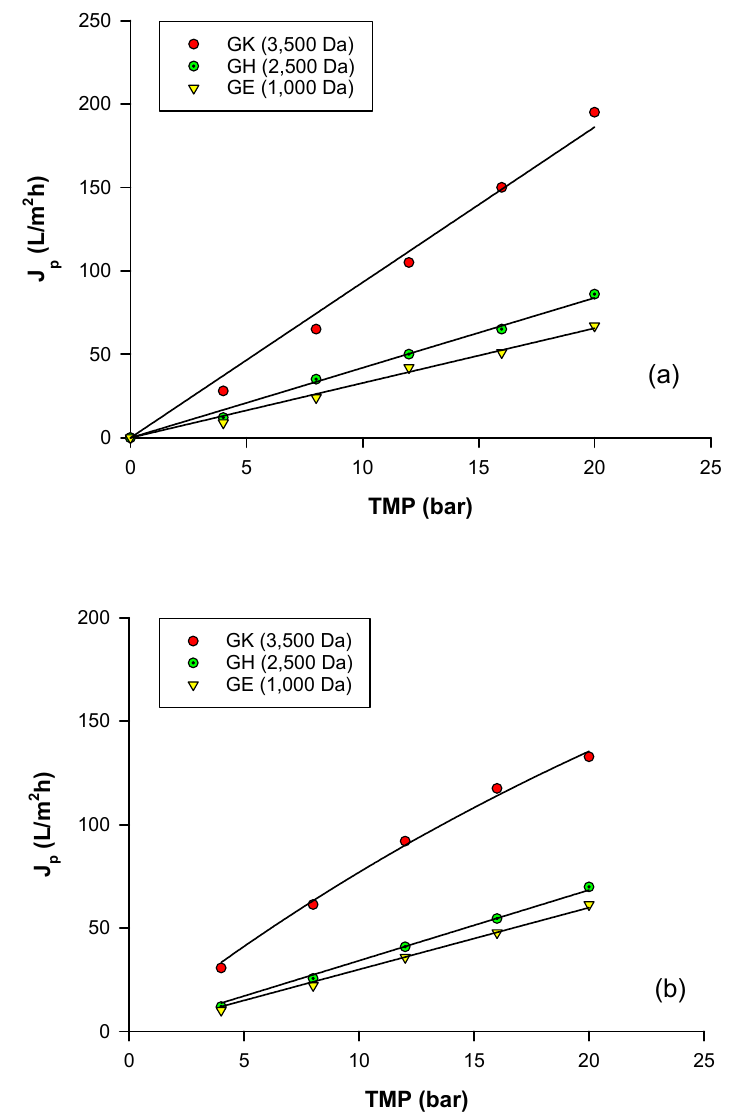
Figure 3. Permeate flux as a function of applied transmembrane pressure (TMP) for selected membranes with: ( a ) deionized water; ( b ) clarified Goji berries extract.